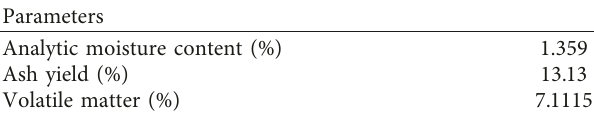
Table 1: Proximate analysis of tested